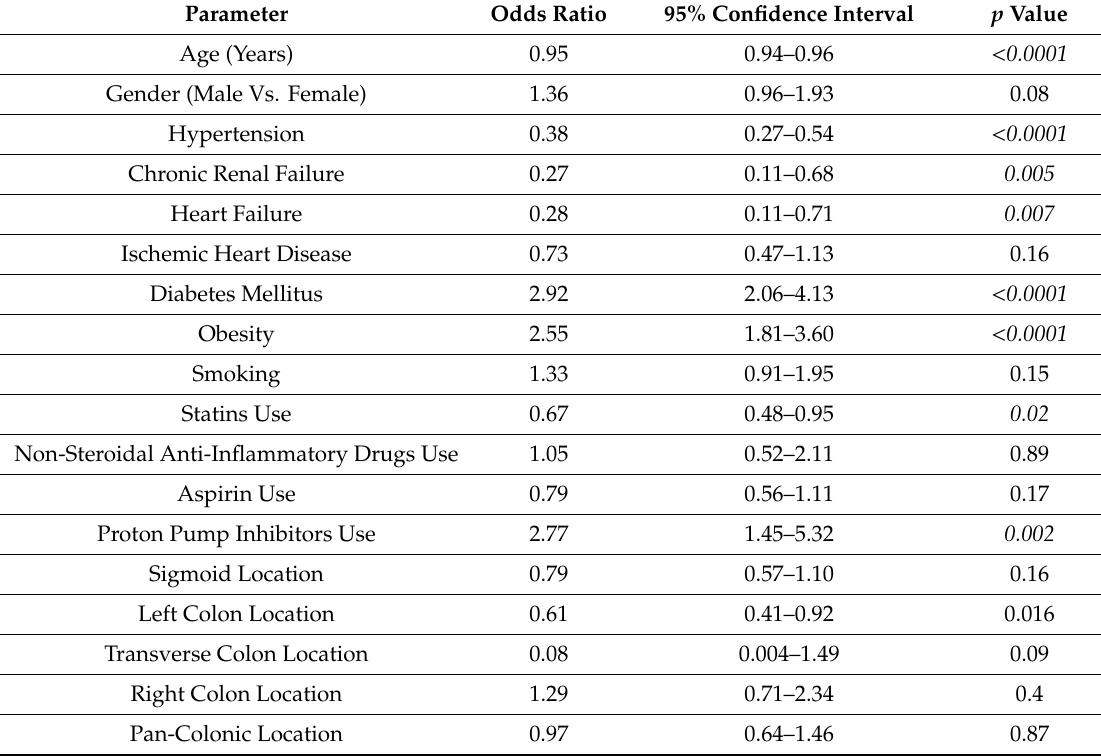
Table 2. Univariate analysis of parameters associated with